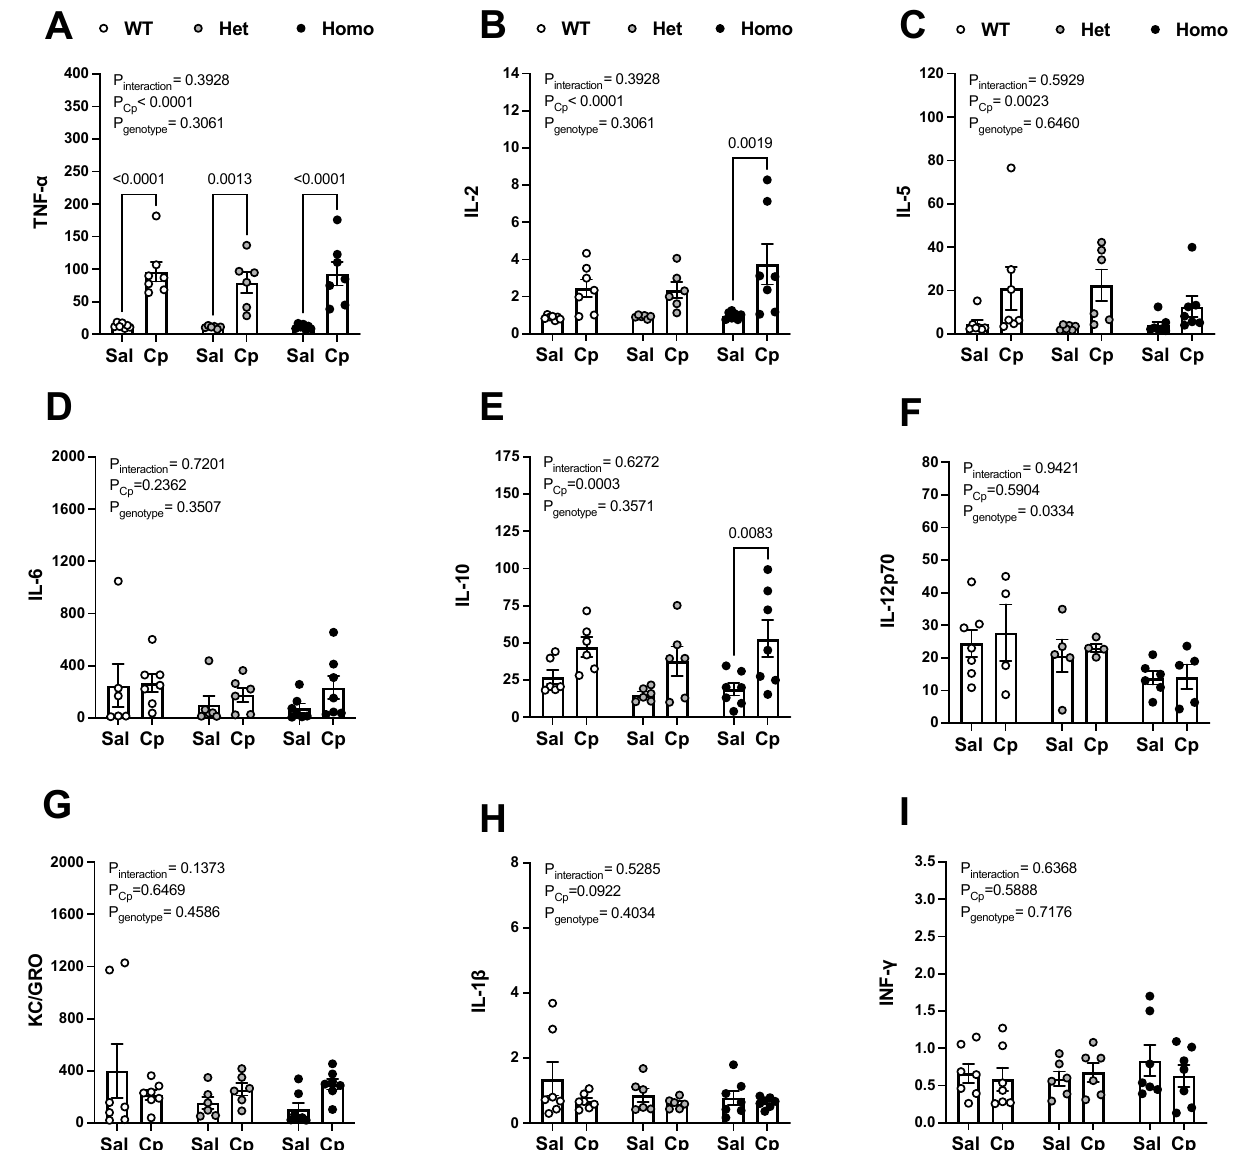
Figure 4. Effect of GPER1 deletion on serum levels of inflammatory cytokines in cisplatin-treated mice. Serum levels of tumor necrosis factor- α (TNF- α , ( A )), interleukin-2 (IL-2, ( B )), IL-5 ( C ), IL-6 ( D ), IL-10 ( E ), IL-12p70 ( F ), keratinocyte chemoattractant-growth-regulated oncogene (KC/GRO, panel ( G )), IL-1 β ( H ), and interferon- γ (INF- γ , ( I )) measured in pg/mL on day 3 after cisplatin (Cp, 20 mg/kg) or saline injections in male mice, homozygous (homo) and heterozygous (het) knockout for GPER1 gene, and wild-type (WT) littermates are demonstrated. Data are presented as mean ± SEM (n = 4–7 mice/group). Statistical comparisons were performed by two-way ANOVA with Sidak’s post hoc test for multiple comparisons ( A – I ). p values for ANOVA and post hoc test results are displayed on the figures. Cp, cisplatin; Het: heterozygous knockout for GPER1 gene; HO-1, heme oxygenase; Homo, homozygous knockout for GPER1 gene; INF- γ , interferon- γ ; IL, interleukin; KC/GRO, keratinocyte chemoattractant-growth-regulated oncogene; Sal, saline; TNF- α , tumor necrosis factor- α ; WT, wild-type.